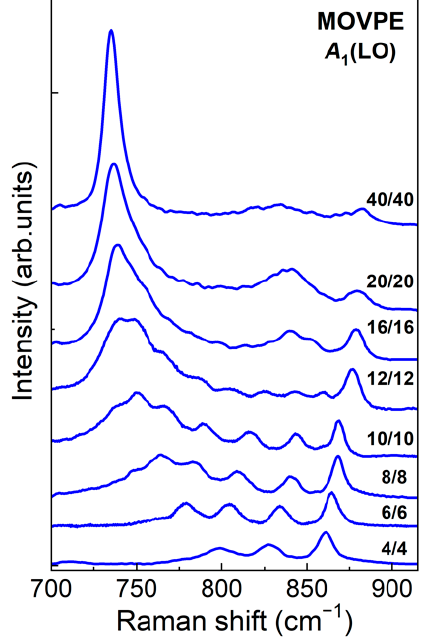
Figure 8. Experimental 𝑧(𝑥𝑥)𝑧̅ Raman spectra of (GaN) m /(AlN) m SLs with different periods.